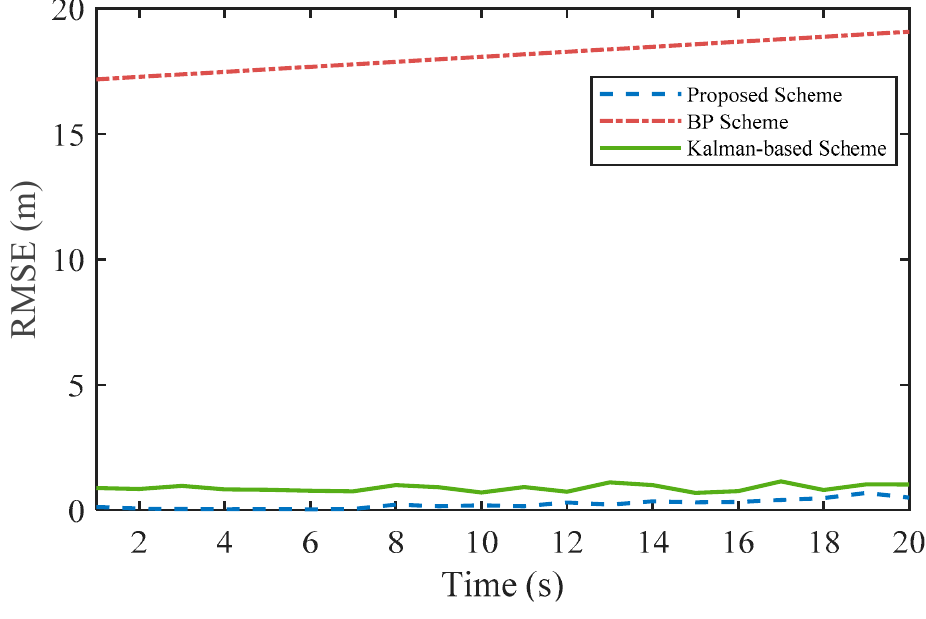
Figure 4. RMSE for the localization scheme.